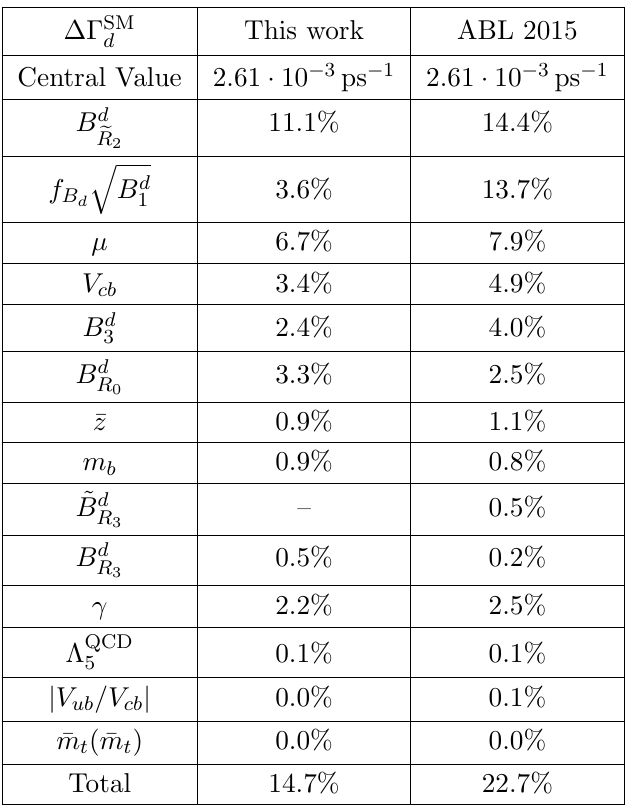
Table 9 . List of the individual contributions to the theoretical error of the mixing quantity (cid:1)(cid:0) d and comparison with the values obtained in 2015 [31]. We have used equations of motion in the current analysis to get rid of the operator ~ R 3 .